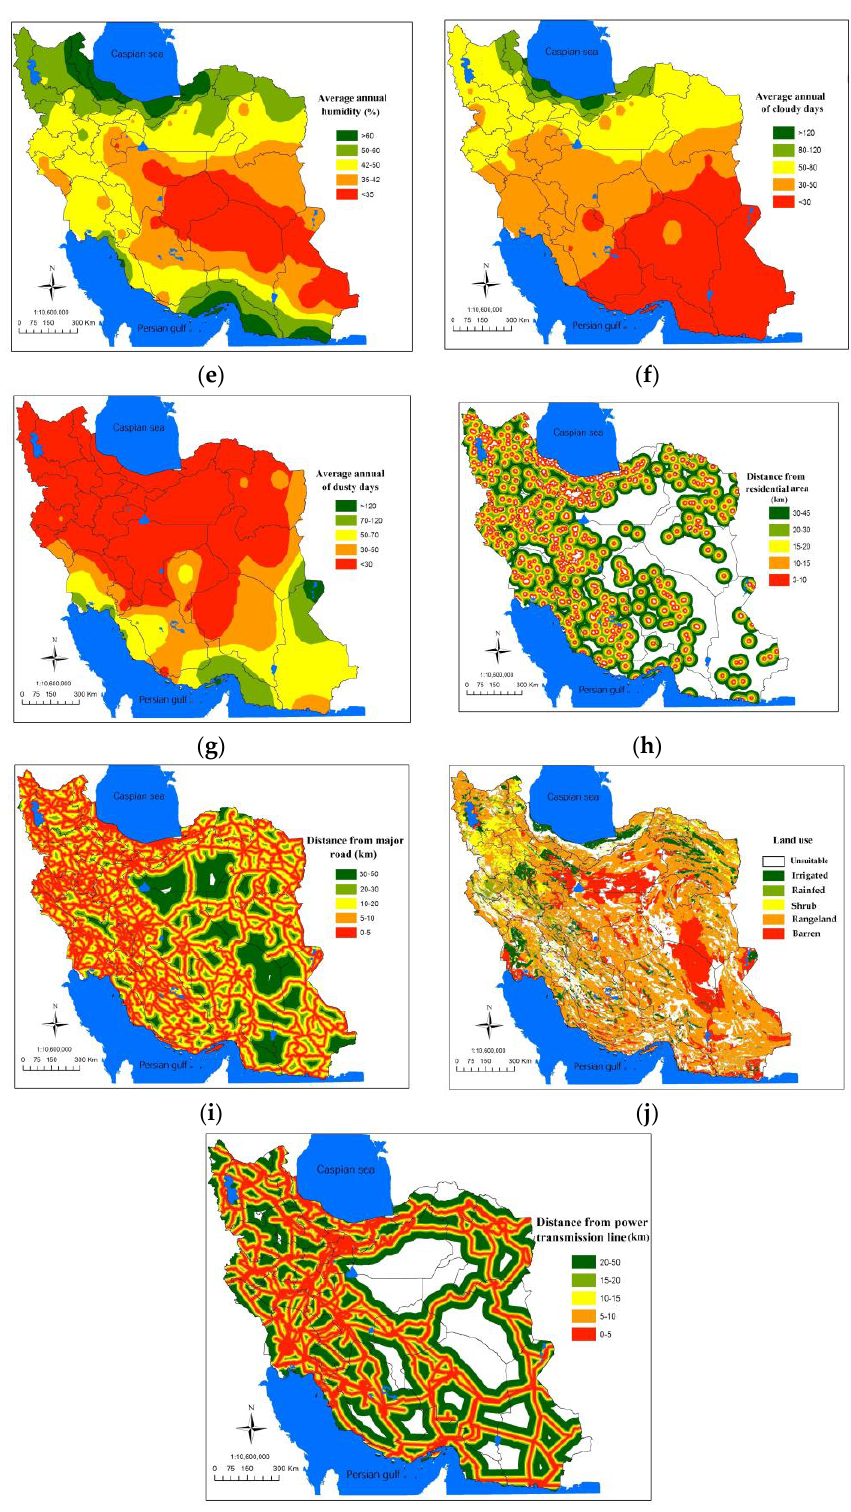
Figure 5. Evaluation criteria layers for land Suitability analysis: ( a ) elevation criterion; ( b ) slope criterion; ( c ) solar radiation criterion; ( d ) average annual temperature criterion; ( e ) average annual humidity criterion; ( f ) average annual of cloudy days criterion; ( g ) average annual of dusty days criterion; ( h ) distance from residential area criterion; ( i ) distance from access road criterion; ( j ) land use criterion; and ( k ) distance from power transmission lines criterion.